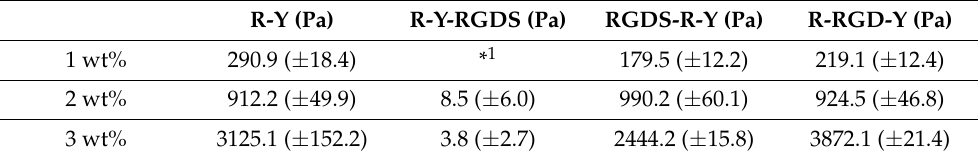
Figure 2. Results of rheology measurement for 2 wt% hydrogel. ( A ) R-Y, ( B ) R-Y-RGDS, ( C ) RGDS-R-Y, ( D ) R-RGD-Y. Blue dot; G’, Rad dot: G’. Table 3. Results of G’ value of rheological analysis for various peptide